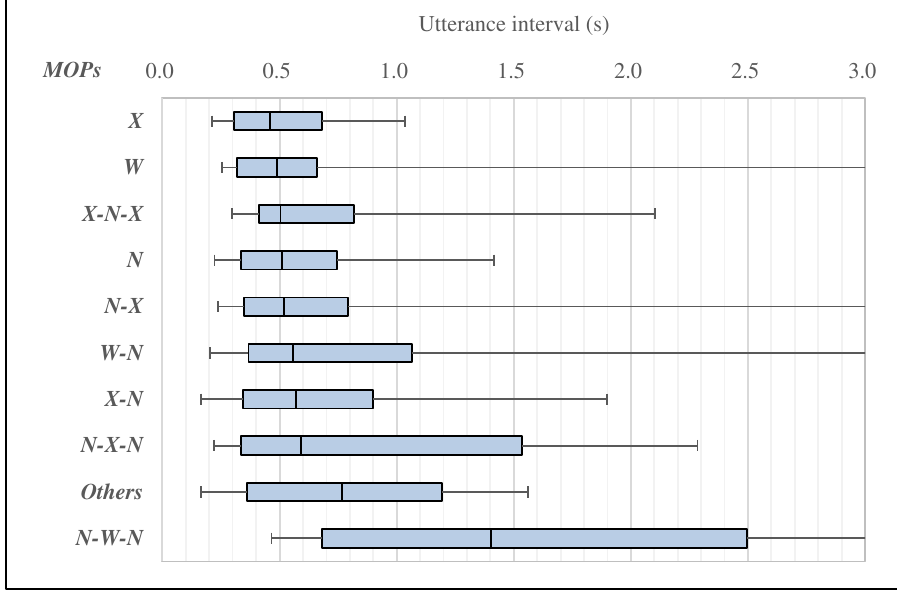
Figure 7. Box plot of utterance interval for each MOTP of listeners during